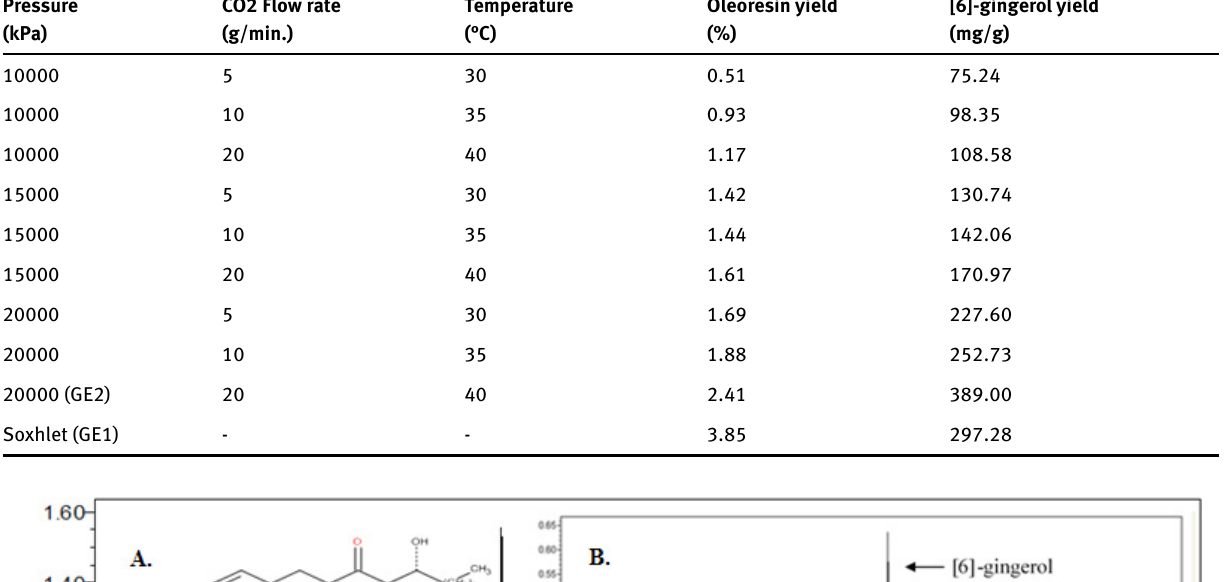
Table 1: Yield of ginger oleoresin and [6]-gingerol obtained after Soxhlet and SC-CO